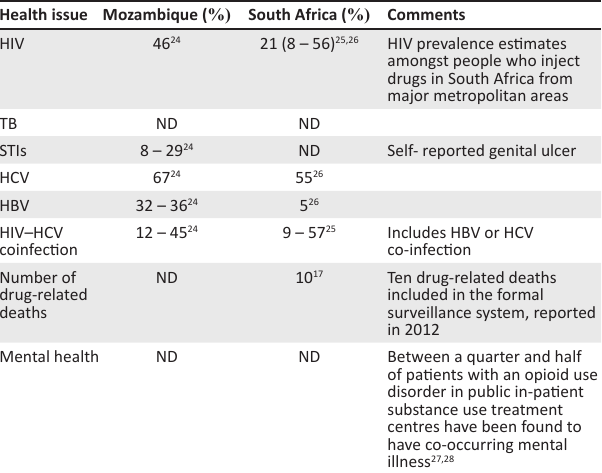
TABLE 4: Overview of infectious disease prevalence and morbidity amongst people who inject drugs (latest data). Health issue Mozambique ( %) South Africa ( %) Comments